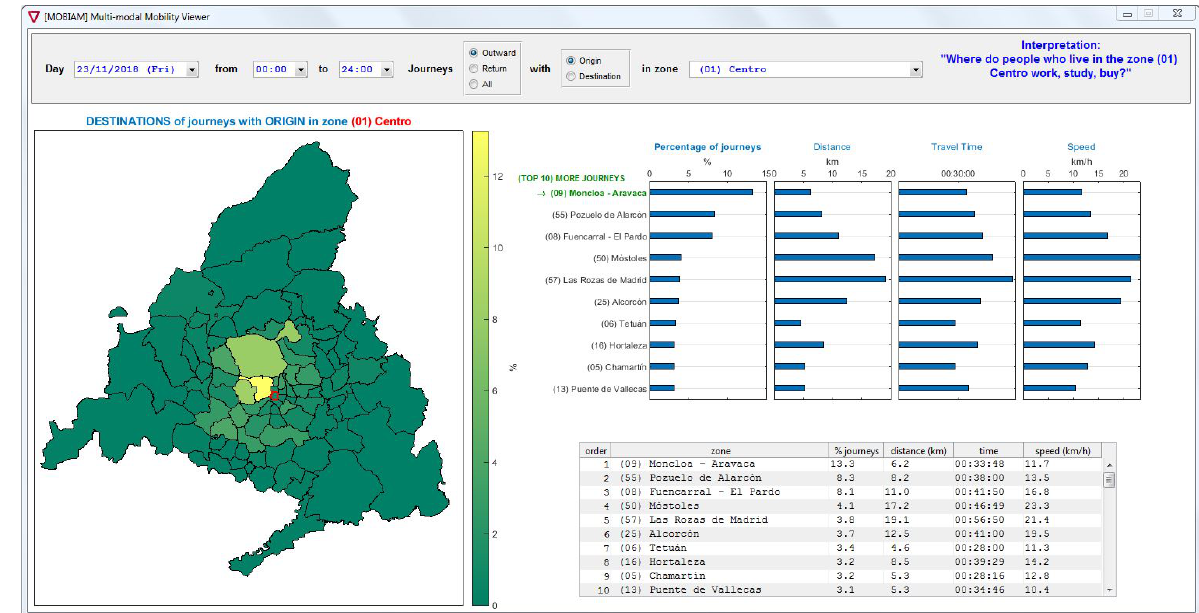
Figure 6. Screenshot of the software tool.